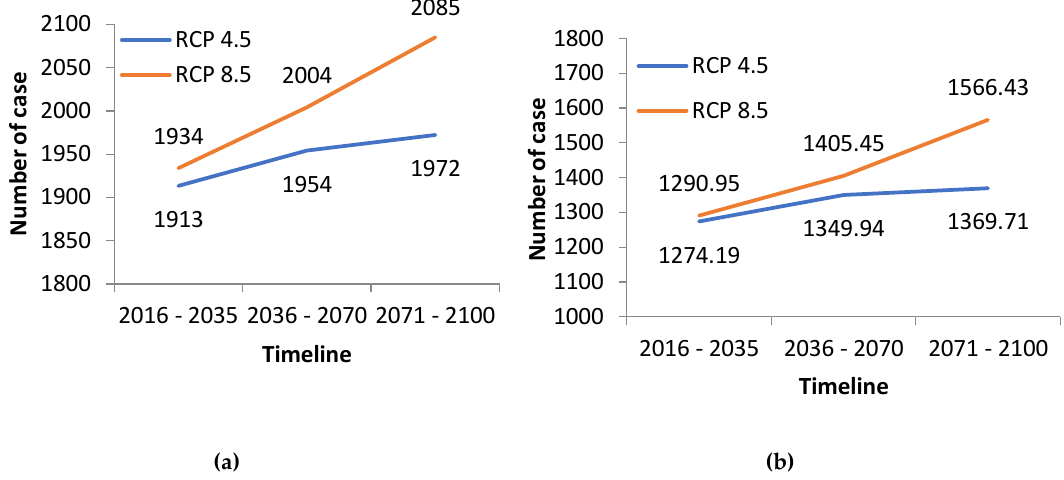
Figure 5. Projected trends of ( a ) Malnutrition in Antananarivo and ( b ) Malaria in Morondava.